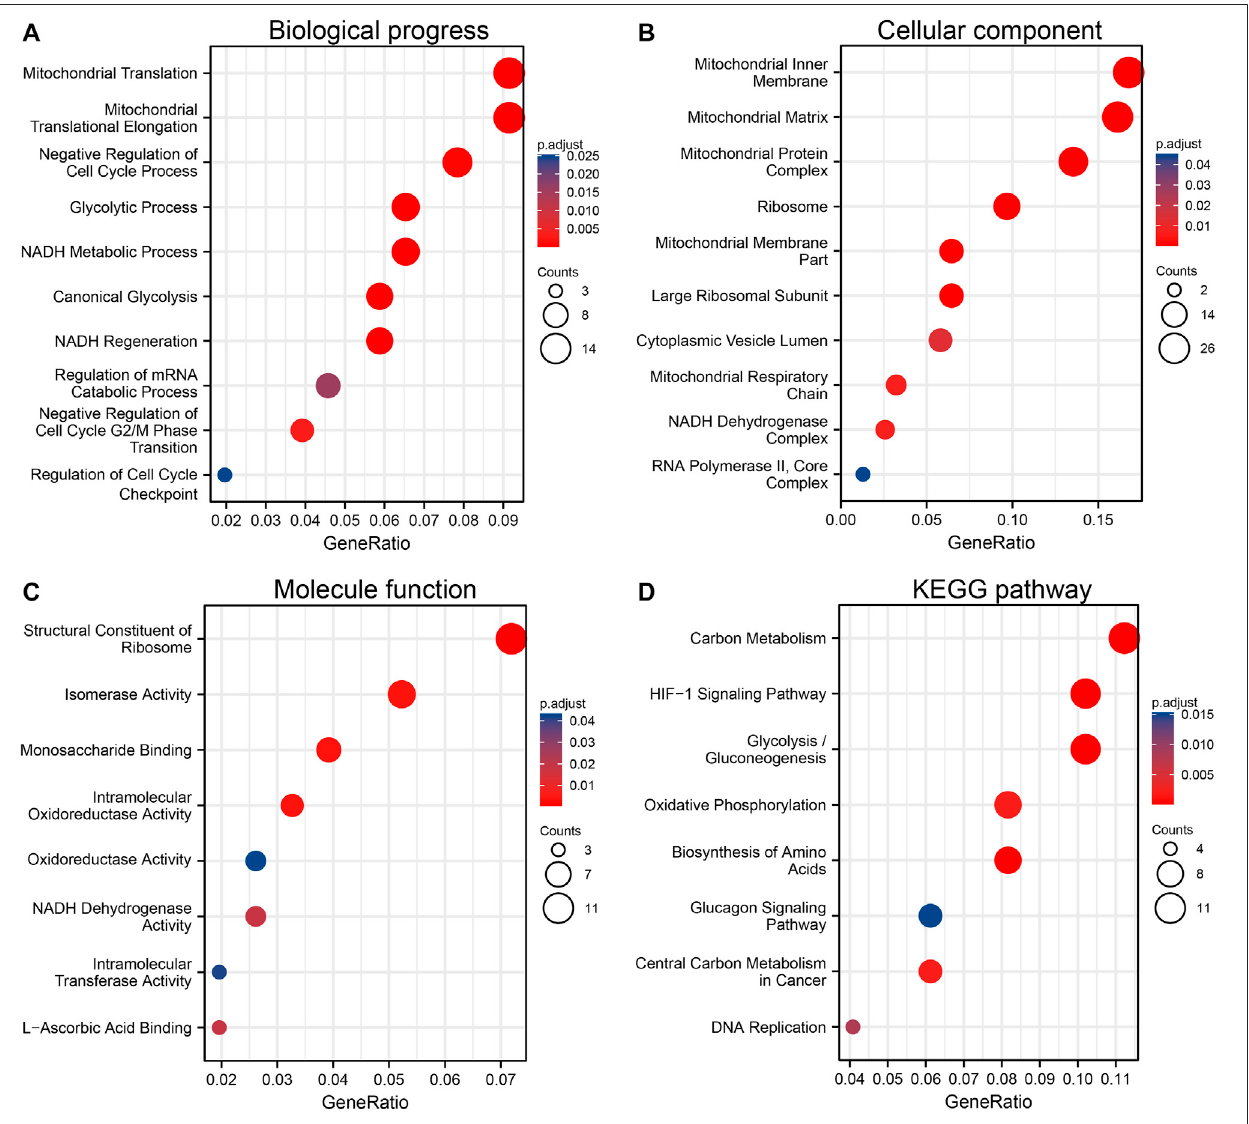
FIGURE 8 | Functional enrichment analysis of positively co-expressed genes of ALDOA . (A) Biological progress of mitochondrial translation, mitochondrial translational elongation, and negative regulation of cell cycle progress (B) Cellular component of the mitochondrial inner membrane, mitochondrial matrix, and protein complex (C) Molecule function of the structural constituent of ribosome, isomerase activity, and monosaccharide binding (D) KEGG pathway analysis showed enrichment function in carbon metabolism, HIF-1 signaling pathway, and glycolysis/gluconeogenesis.